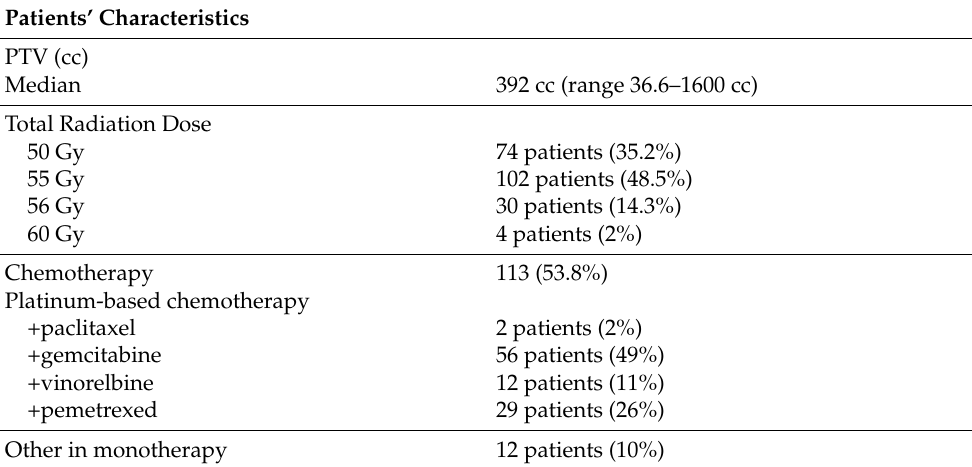
Table 2. Pattern of Treatment: Radiation and Systemic